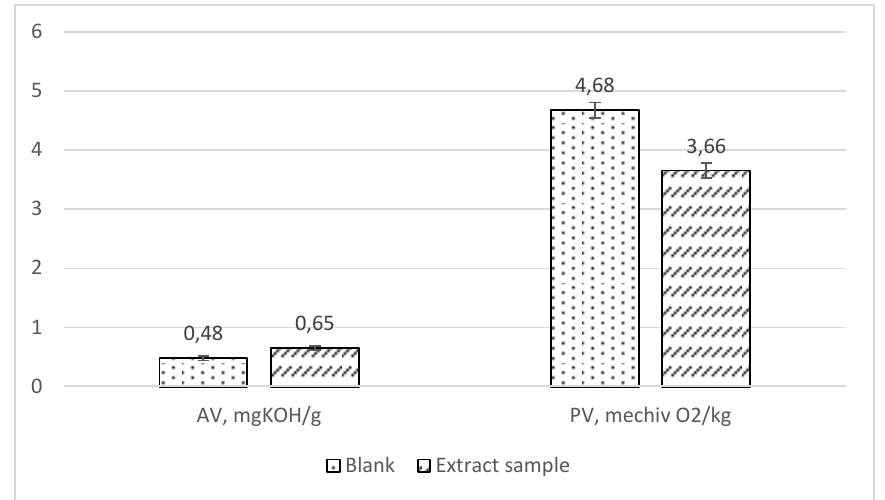
Figure 3. Physico-chemical characteristics of mayonnaise type